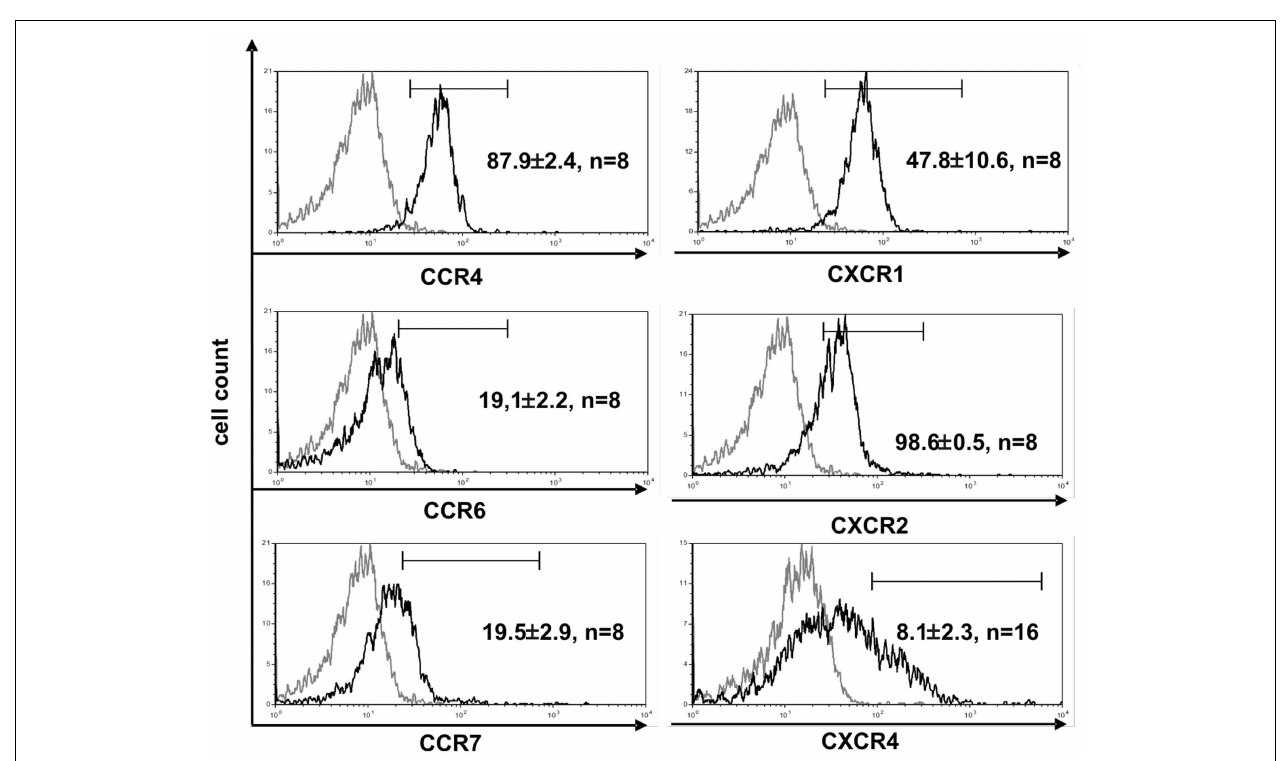
Numbers indicate mean ± SEM of CD4 + V δ 1 + T cells that stain positive for the respective marker (given in %). Each histogram shows one representative experiment of all clones tested. Numbers of clones tested are given in each histogram. Gray line: isotype